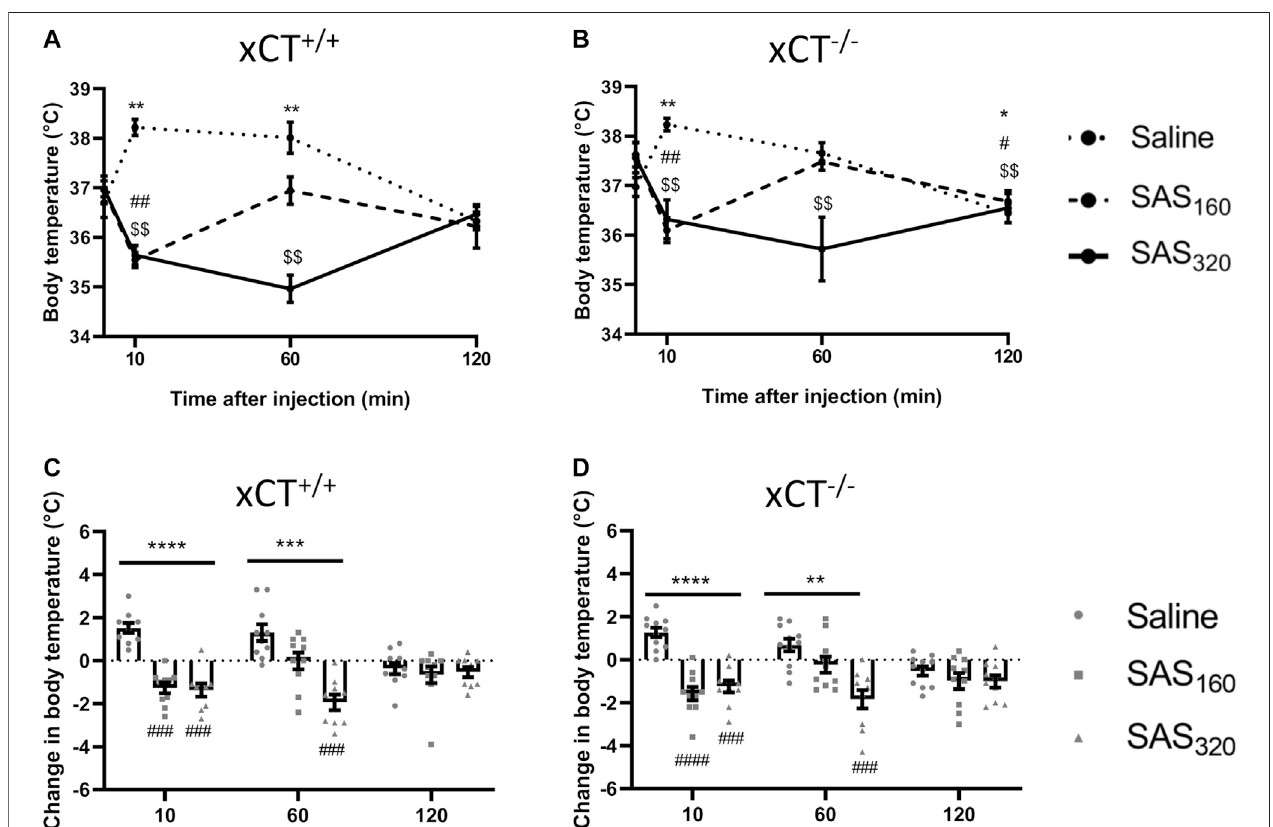
FIGURE 4 | The effect of chronic sulfasalazine (SAS) treatment on changes in body temperature after injection. After four weeks of treatment, body temperature wasmeasured10,60and120 minafterSASinjectionandplottedasabsolutevalues (A,B) orasthedifferencecomparedtothebodytemperaturebeforeinjection (C,D) ( n (cid:2) 9 – 10xCT +/+ mice/group (A,C) ; n (cid:2) 10 – 11xCT − / − mice/group (B,D) ).Dataarepresentedasmean ± SEMandanalyzedusingaWilcoxonmatched-pairssignedrank test for each treatment paradigmat the different timepoints compared to baseline (A – B):saline: * p < 0.05, ** p < 0.01; SAS 160 : # p < 0.05, ## p < 0.01; SAS 320 : $$ p < 0.01. A Kruskal-Wallis test (C-D; ** p < 0.01, *** p < 0.001, **** p < 0.0001) followed by Dunn ’ s multiple comparison was used to compare each dose of SAS to saline on each timepoint ( ### p < 0.001, #### p < 0.0001).